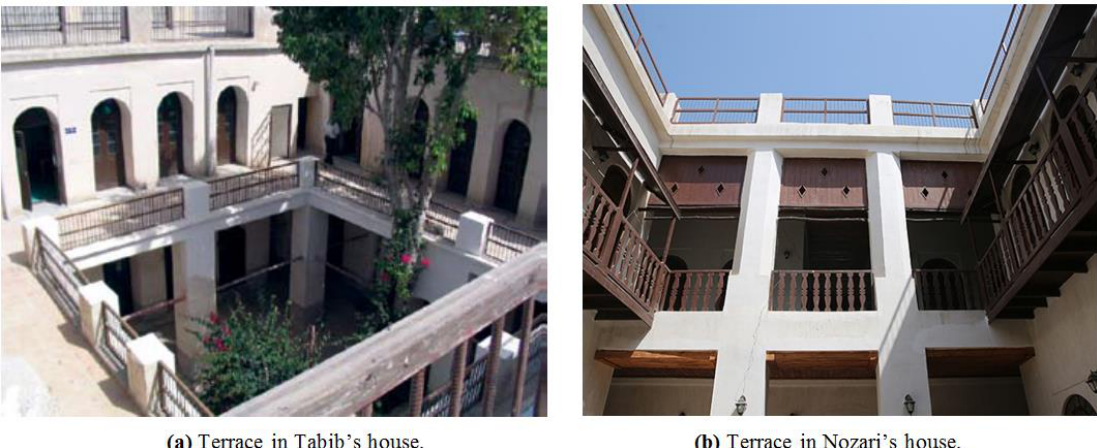
Figure 7 . External and internal Shenashir in Tabib’s and Nozari’s houses. Figure 7. External and internal Shenashir in Tabib’s and Nozari’s houses.